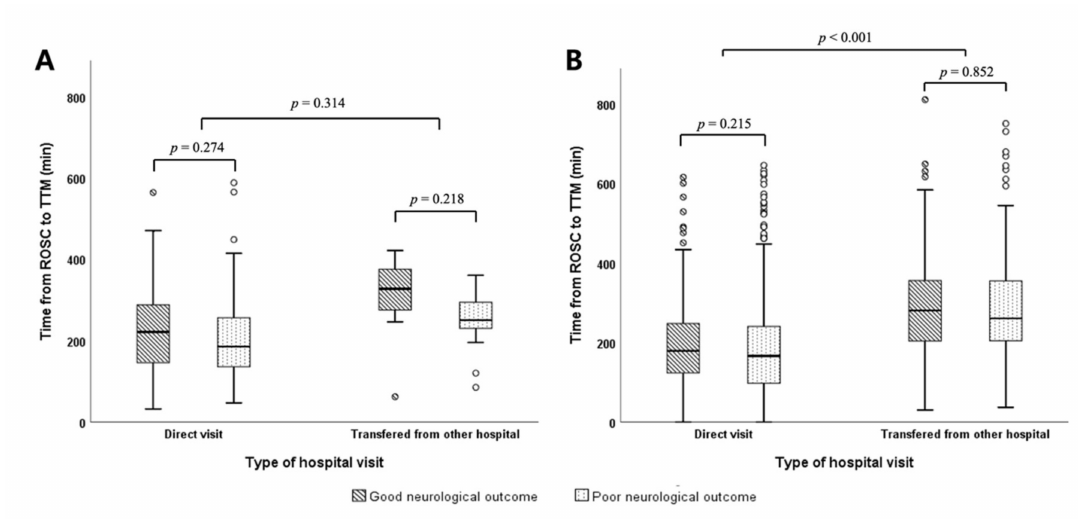
Figure 2. Comparison of the time from return of spontaneous circulation to the induction of targeted temperature management between the direct visit and transfer groups and between the good and poor neurological outcome groups. ( A ) ST elevation group. ( B ) Non-ST elevation group ROSC: return of spontaneous circulation; TTM: targeted temperature